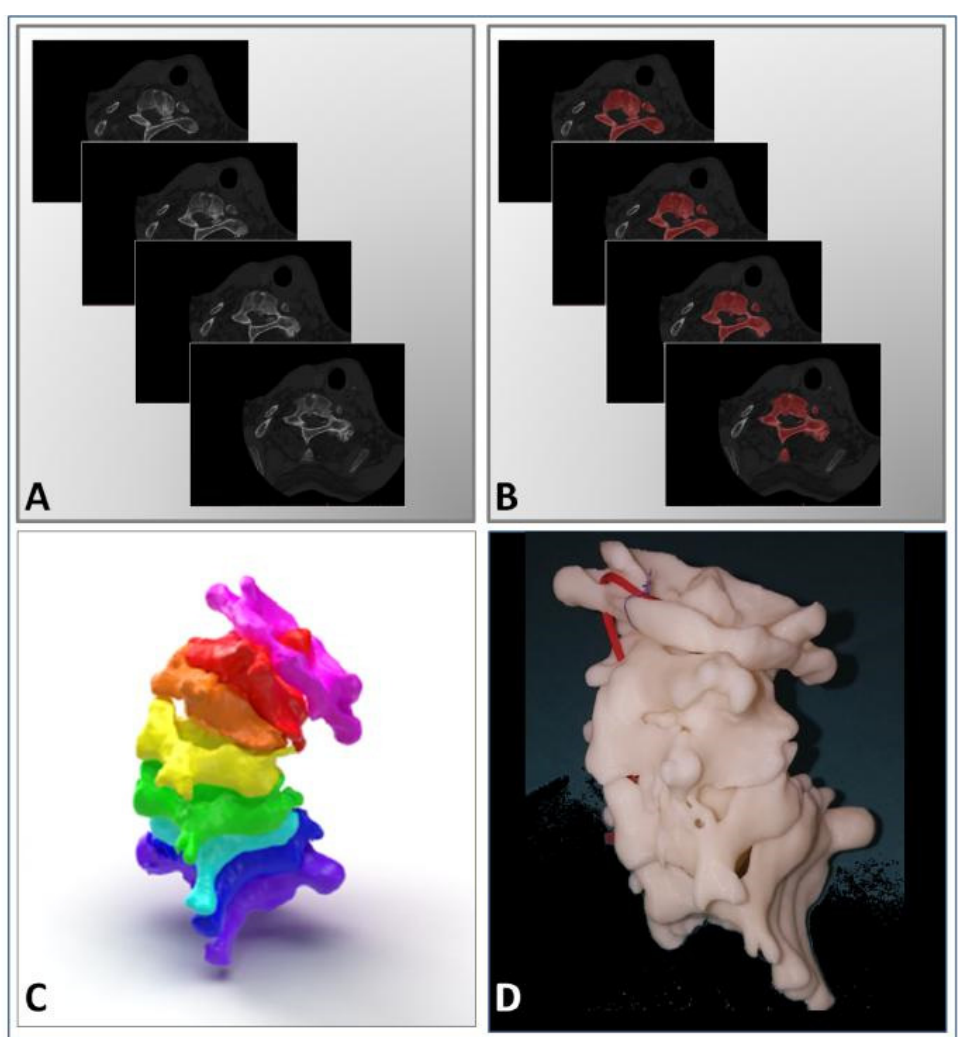
Figure 2. 3D model reconstruction of the pre-operative cervical spine. DICOM images are imported in a dedicated software ( A ), where the bone vertebral bony contours, along with the internal bony structures, are identified and marked by the operator ( B ); all detected contours are then merged to create the 3D virtual model for the overall C1-to-T1 spine section (i.e., PRE-VIR) and for each single vertebra (( C ), each vertebra was marked using a different colour). Afterwards, the reconstructed virtual model was manufactured via 3DP (PRE-3DP) and a plastic red wire mimicking the cervical artery was inserted in the relevant printed vessel course ( D